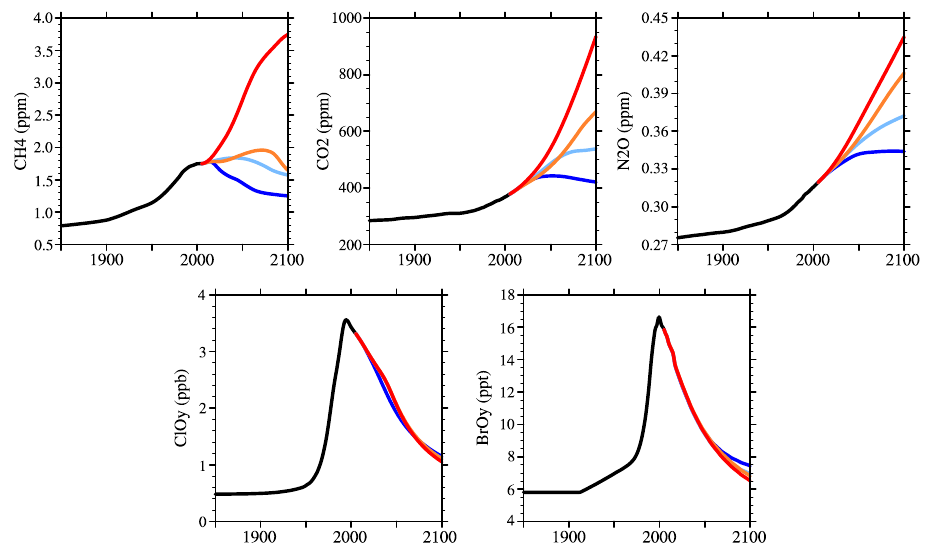
Fig. 2. Time evolution of global-averaged mixing ratio of long-lived species 1850–2100 following each RCP; blue (RCP2.6), light blue (RCP4.5), orange (RCP6.0) and red (RCP8.5). ClOy and BrOy are the total organic chlorine and bromine compounds, respectively, summa- rizing the evolution of ozone-depleting substances. All values from Meinshausen et al. (2011).